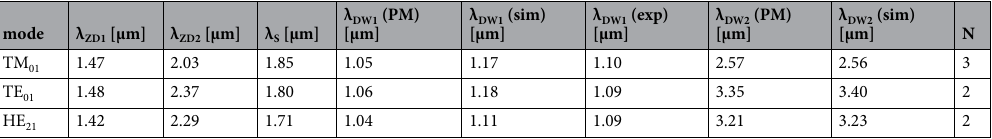
Table 1. Comparison of soliton and DW wavelengths. The wavelengths of DWs are obtained by phase- matching calculations (PM), nonlinear simulations (sim) and experiments (exp) for TM 01 , TE 01 and HE 21 mode in a 3.9 µm CS 2 -core fiber at 400 pJ. The soliton number N is calculated for the indicated soliton wavelength λ S